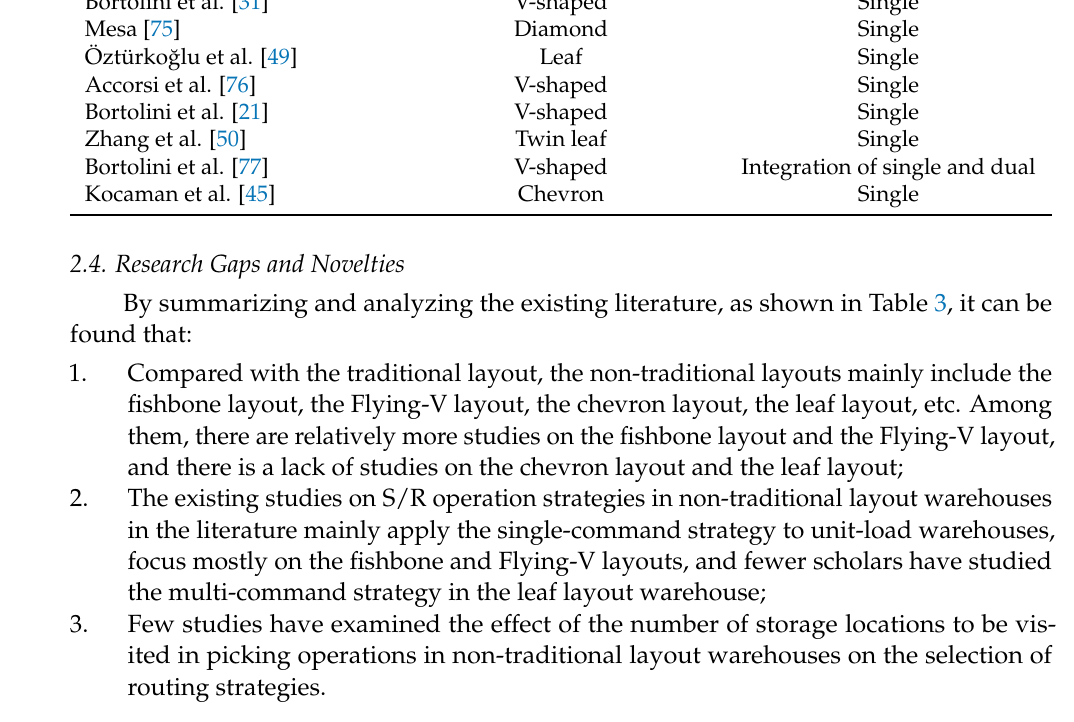
Table 3. Comparison with the existing